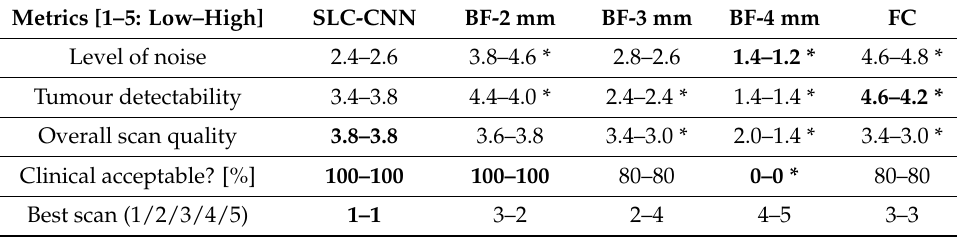
Table 4. Qualitative assessment of the 89 Zr-rituximab PET scans. Scores were given for the PET scans with (SLC-CNN and BF) and without (FC) denoising by both Nuclear Medicine Physicians. In bold the best performing method (or scan) is indicated based on the average score of both